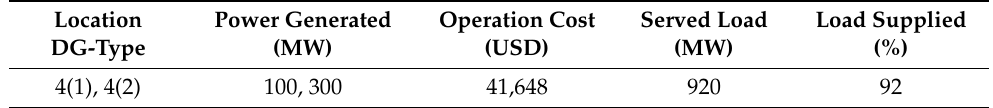
Table 10. Operation after locating DG.